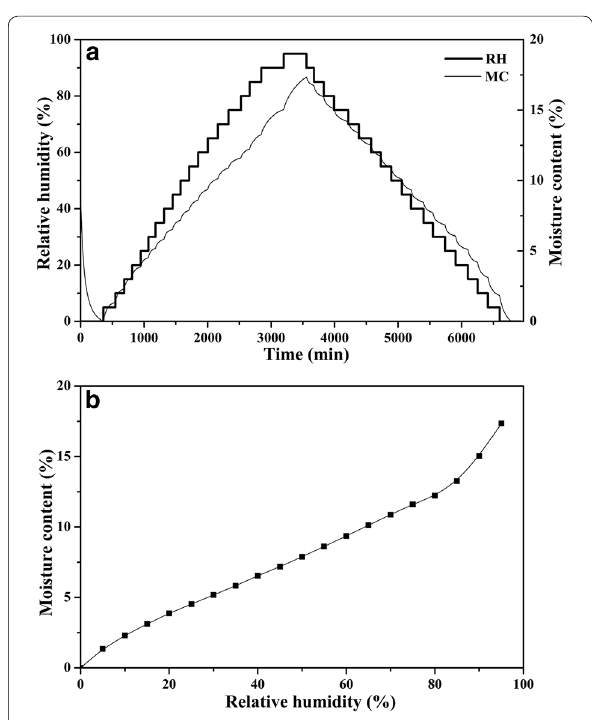
Fig. 7 a Change in moisture content of heat-treated wood with the varying RH levels over the time profile in the isotherm run. b Equilibrium moisture content of heat-treated wood over the full set RH range in the adsorption